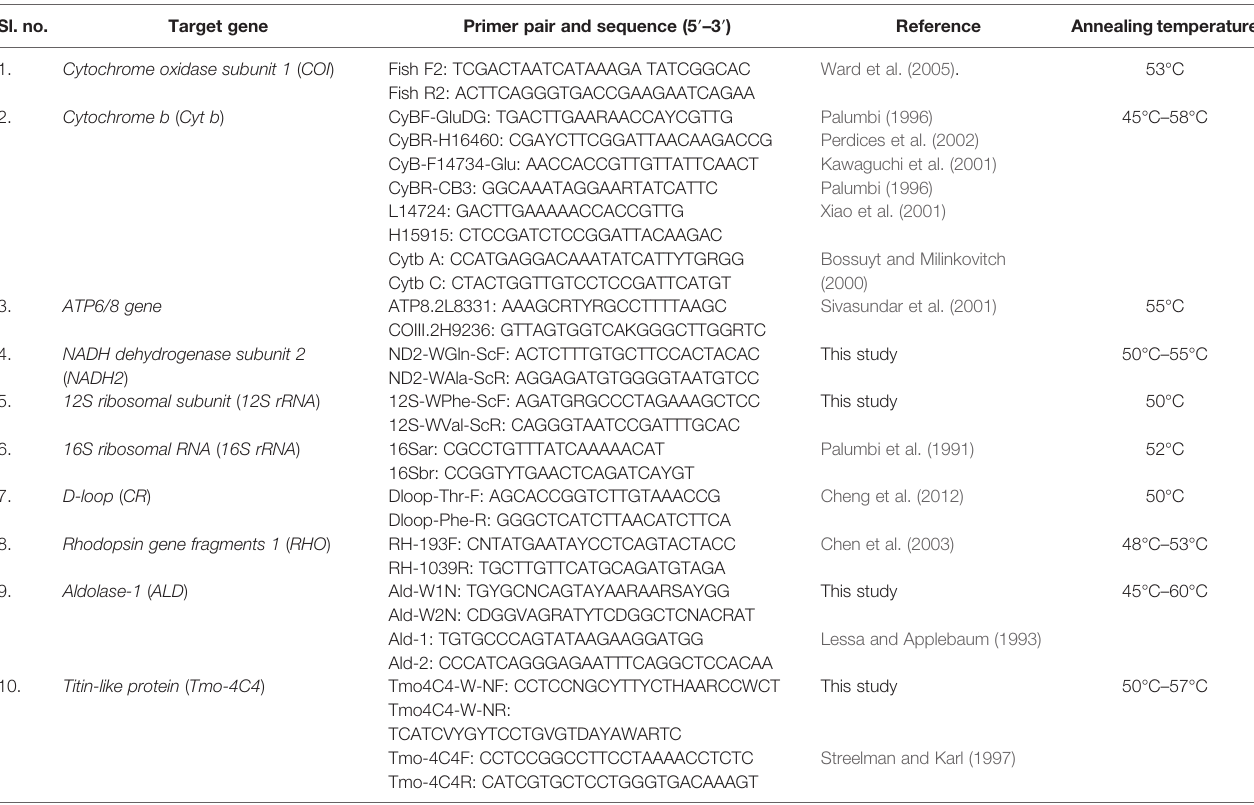
TABLE 3 | Details of the PCR primers used in this study. Sl.